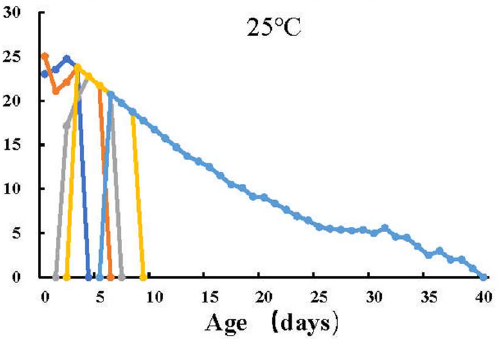
Figure 2. Age-stage-specific life expectancy (e xj ) of Uroleucon formosanum . N1, first instar nymph; N2, second instar nymph; N3, third instar nymph; N4, fourth instar nymph; A, adult.